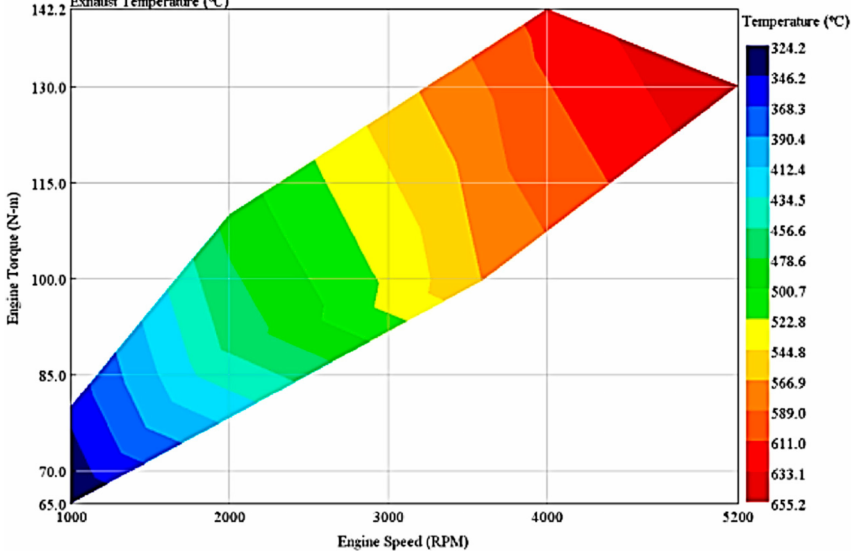
Figure 17. Engine Exhaust